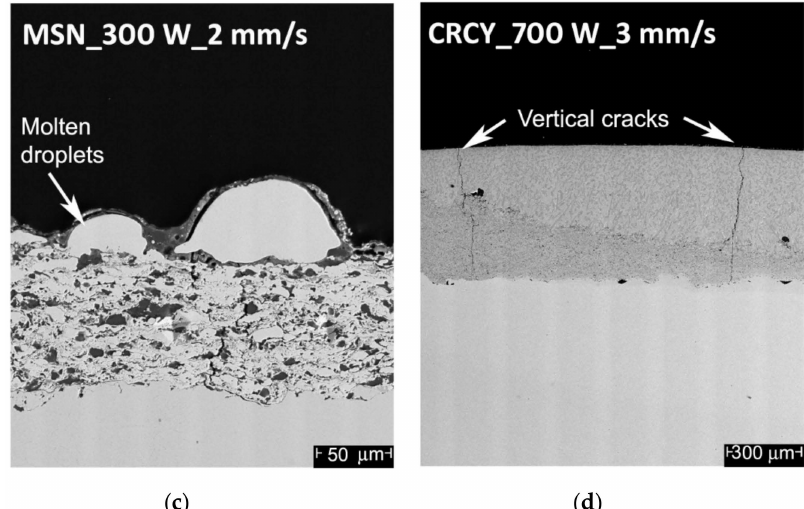
Figure 2. Potential undesired e ff ects of the laser interaction with the coating: ( a ) Vertical cracks; ( b )incorporationoftheassistgasinsidethemoltenmaterialandformationoftheresidualmacro-porosity; ( c ) selective remelting or evaporation and recondensation of the low melting material in surface droplets; and ( d ) partial remelting of the coating with the formation of vertical